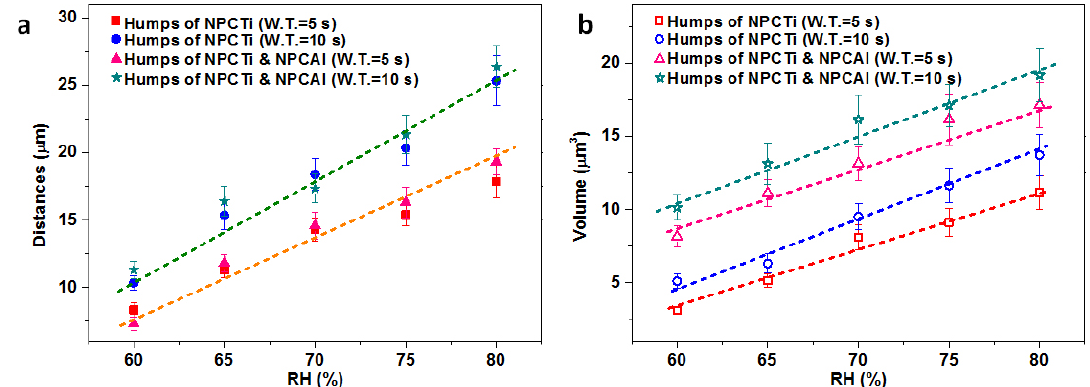
Figure 4. Comparison of distances ( a ) and volumes of humps ( b ) composed of (NPCAl + NPCTi) and NPCTi at different humidity (the error bars indicate the standard deviations of the results).